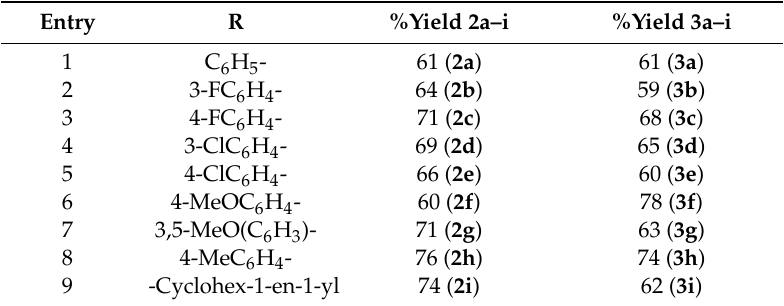
Table 1. Substitution pattern and percentage yields of 2a – i and 3a – i